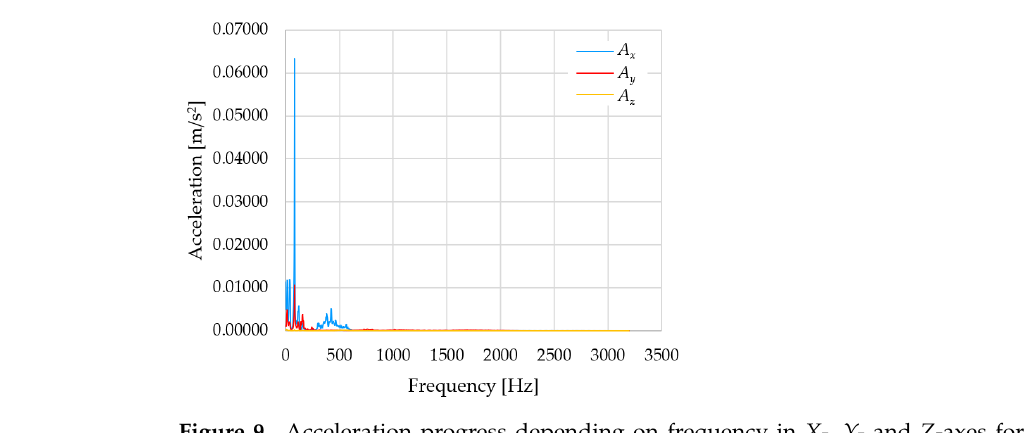
Figure 9. Acceleration progress depending on frequency in X- , Y- and Z -axes for velocity 20% (26.2°/s).